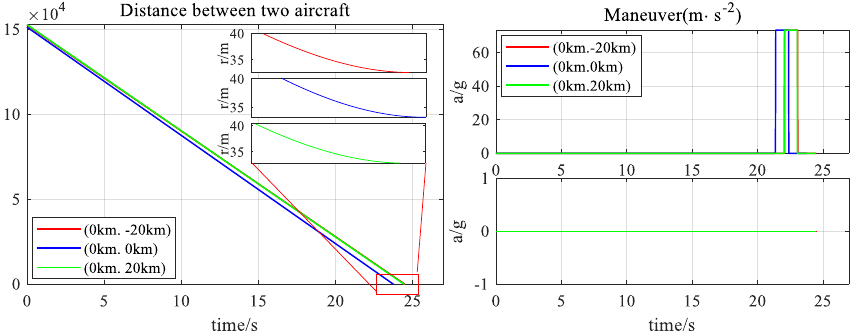
Figure 11. Evader utilizing MS-DDQN maneuvers with the three different initial relative positions ( 0km, − 20km ) , ( 0km,0km ) , and ( 20km,20km ) in the initial inertial coordinate system.